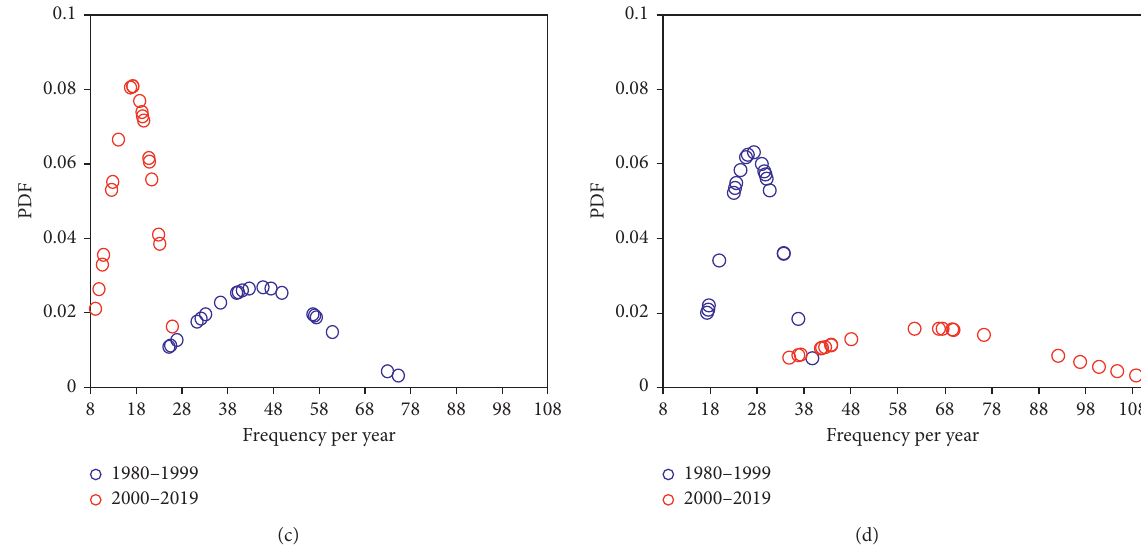
Figure 14: Probability distribution function (PDF) of annual frequency of (a) cold days (TX10p), (b) warm days (TX90p), (c) cool nights (TN10p), and (d) warm nights (TN90p) for Saudi Arabia for two 20-year periods: 1980–1999 (blue) and 2000–2019 (red).